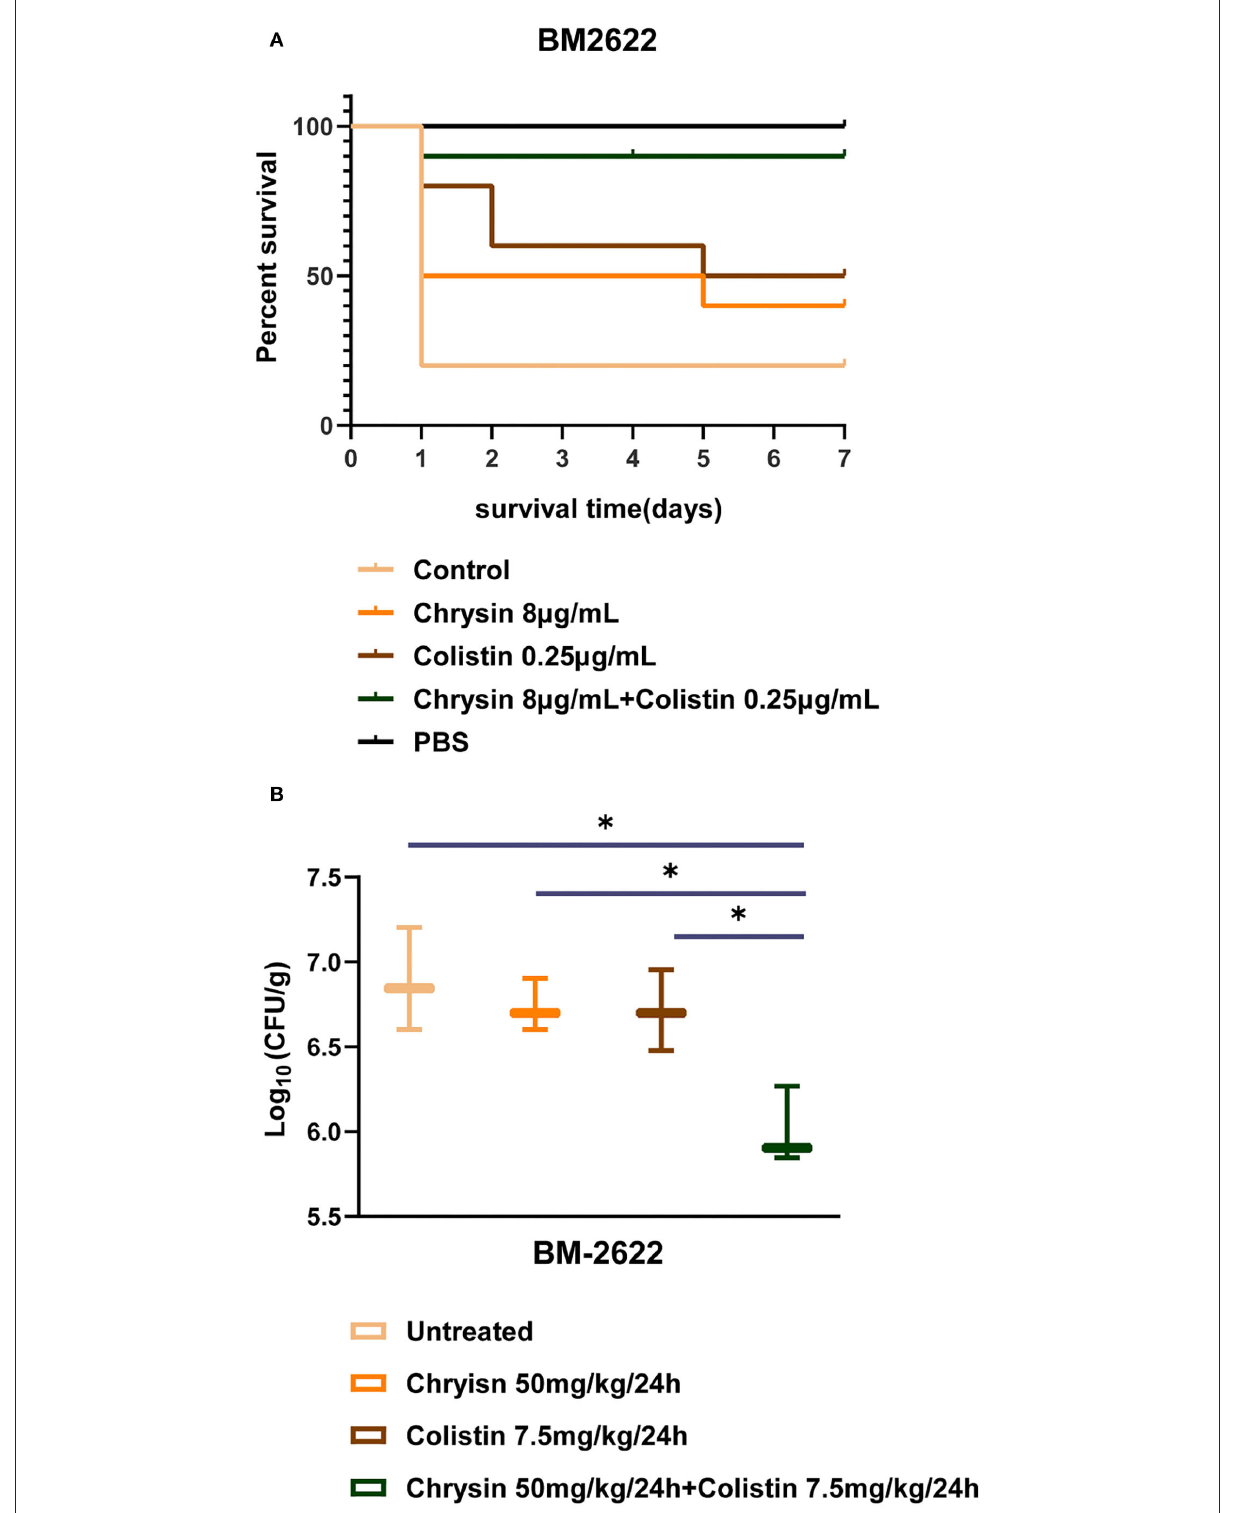
FIGURE4 In vivo experiments of chrysin and colistin. (A) The survival rate of Galleria mellonella after 7 days of monotherapy or combination therapy against colistin-resistant (COL-R) A. baumannii BM2622. (B) A. baumannii BM2622 burden in the mouse thigh model. p < 0.05 (noted with*), data are expressed as the mean ± SD of three